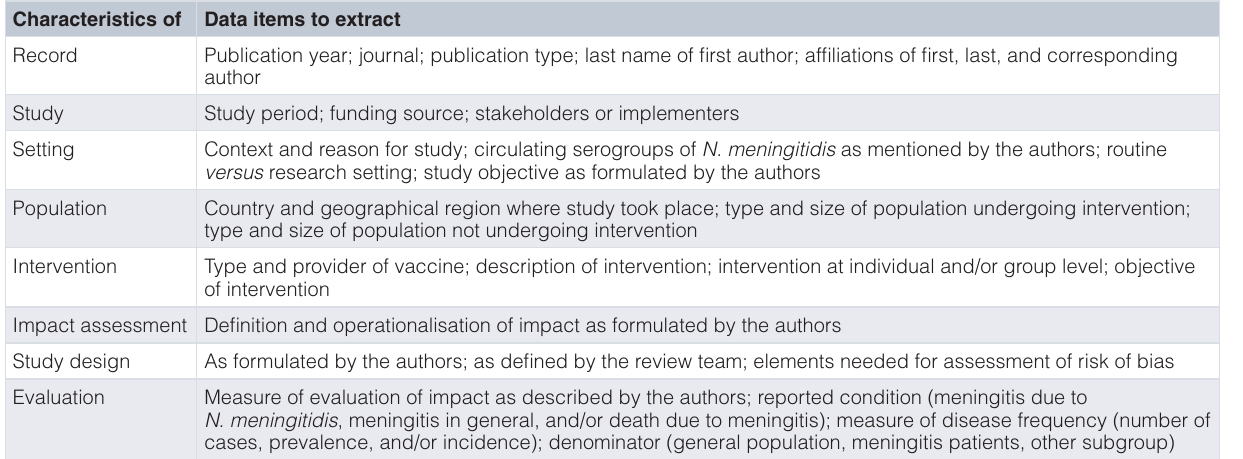
Table 3. Summary of data items to extract. Characteristics of Data items to extract